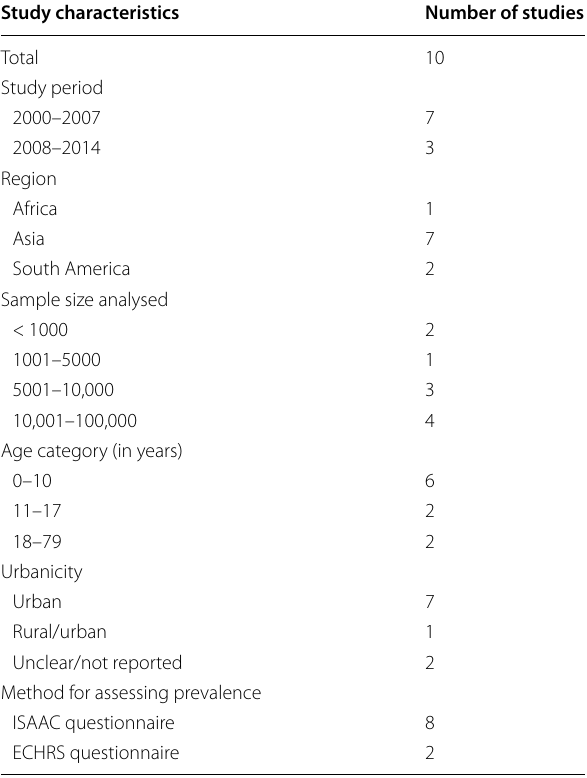
Table 1 Main characteristics of studies included in the